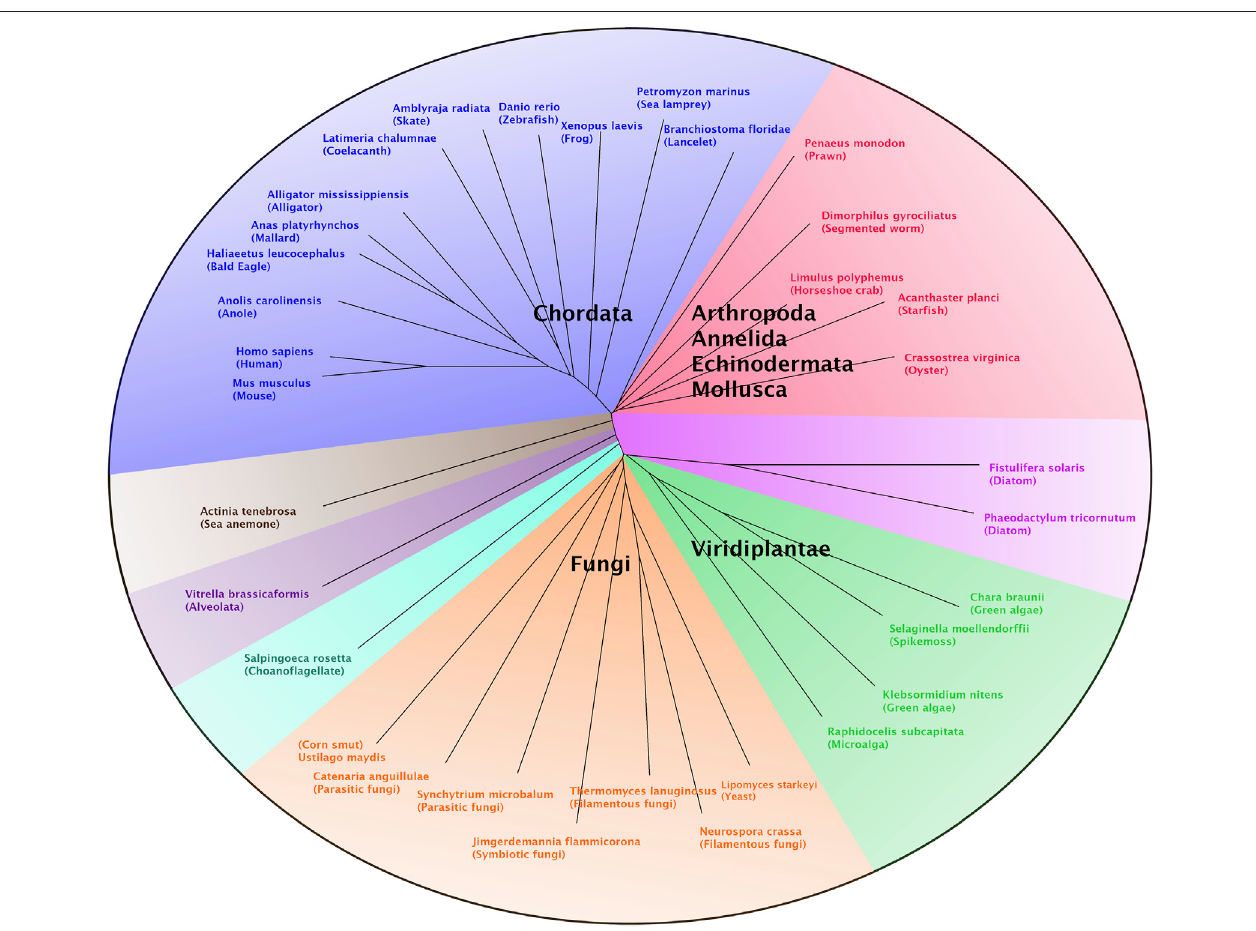
FIGURE 1| Phylogeneticanalysisof pol ι . A multiple sequence alignment of pol ι proteins from abroad range ofeukaryotic organisms, including T. lanuginosus pol ι andhumanpol ι ,wasperformedusingtheClustalWalgorithminMacVector(version15.5.4).ThisalignmentwasexportedfromMacVectorasaNexus fi lewhichwasthen imported into SplitsTree4 (version 4.14.4) to generate an unrooted phylogenetic tree by setting the distance method to BioNJ. Most of the pol ι proteins cluster into severalgroupscomprisedofchordates(blue),loweranimals(red),lowerplants(green),fungi(orange)anddiatoms(pink).Pol ι proteinsequencesforeachorganism were obtained from the following Genbank sequence fi les: Acanthaster planci (XP_022107640), Actinia tenebrosa (XP_031566011), Alligator mississippiensis (XP_006269716), Amblyraja radiata (XP_032889300), Anas platyrhynchos (XP_027302772), Anolis carolinensis (XP_016850726), Branchiostoma fl oridae (XP_035668094), Catenaria anguillulae (ORZ32752), Chara braunii (GBG75489), Crassostrea virginica (XP_022331447), Danio rerio (NP_001017834), Dimorphilus gyrociliatus (CAD5123533), Fistulifera solaris (GAX13589), Haliaeetus leucocephalus (XP_010581340), Homo sapiens (NP_001338561), Jimgerdemannia fl ammicorona (RUP43481), Klebsormidium nitens (GAQ87748), Latimeria chalumnae (XP_005994715), Limulus polyphemus (XP_022236329), Lipomyces starkeyi (ODQ70434), Mus musculus (NP_036102), Neurospora crassa (CAD70389), Penaeus monodon (XP_037797824), Petromyzon marinus